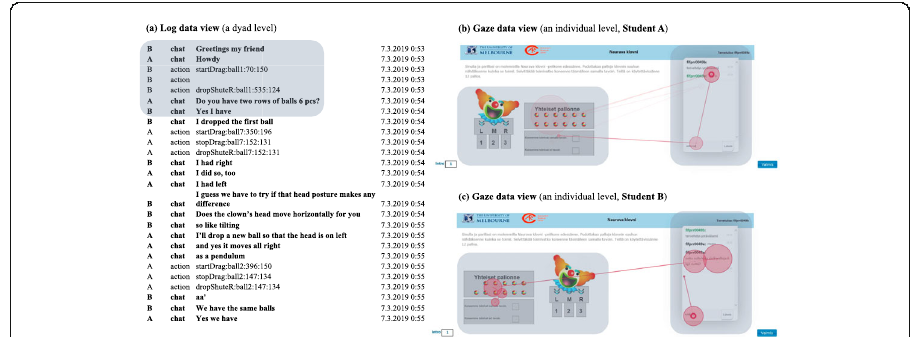
Fig. 6 Illustration of sliding from a mutual to shared attention experience (students A and B perspectives) whilst completing the ‘ Laughing Clowns ’ task. The example includes simultaneous moments from ( a ) the log data, combined with ( b ) and ( c ) individual-level screen captures from the eye-tracking video